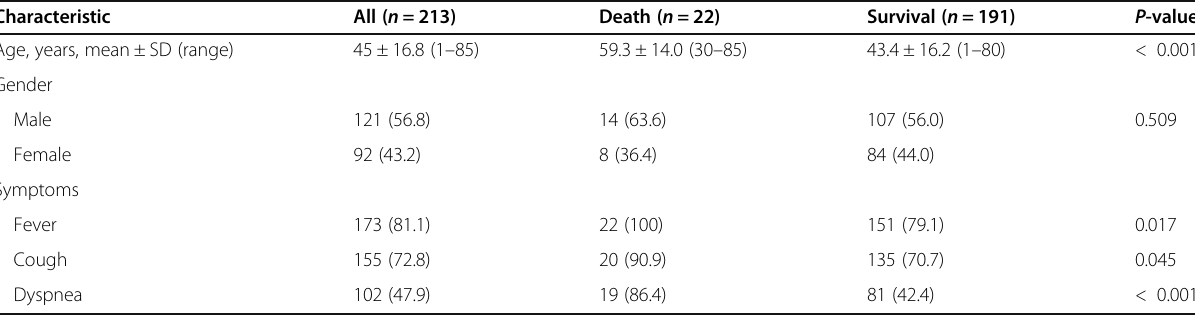
Table 1 Demographic and clinical characteristics of study population Characteristic